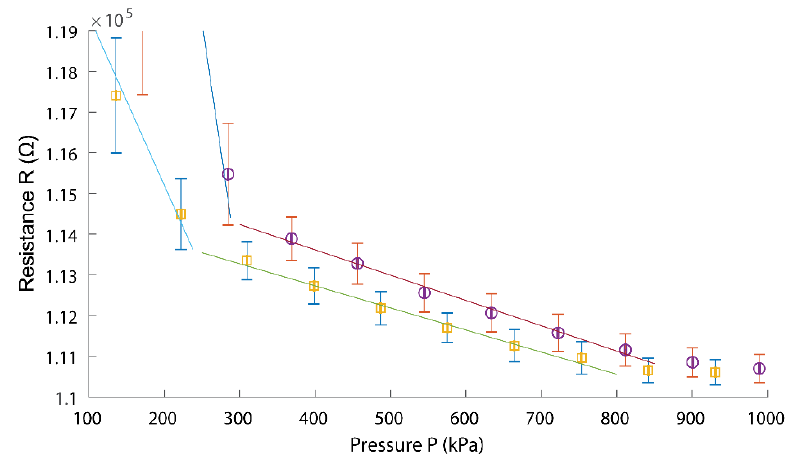
Figure 7. Calibration results where the x–y standard deviation around the mean is represented as error bars, circle indicates compression, and square indicates decompression.